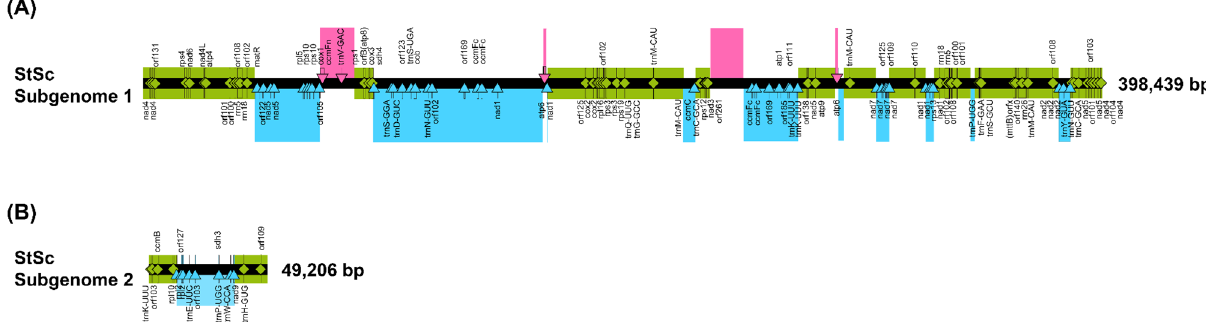
Figure 2. The origin of mitogenome recombination block in somatic hybrid (StSc) ( A ) Subgenome 1 of somatic hybrid mitogenome ( B ) Subgenome 2 of somatic hybrid mitogenome. The pink and sky-blue triangles on the black middle line indicate genes derived from S. tuberosum and S. commersonii , respectively. The green diamond boxes indicate genes of unknown